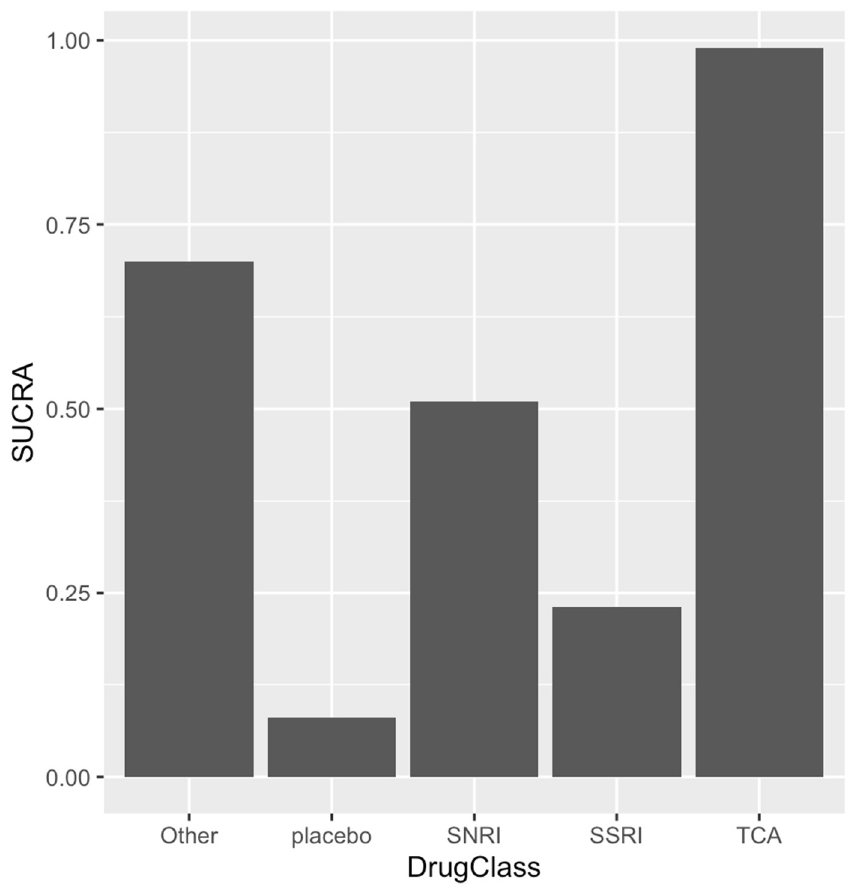
Figure 4. SUCRA graph rank the treatment options according to risk reduction in sudden cardiac death/ventricular arrhythmia.